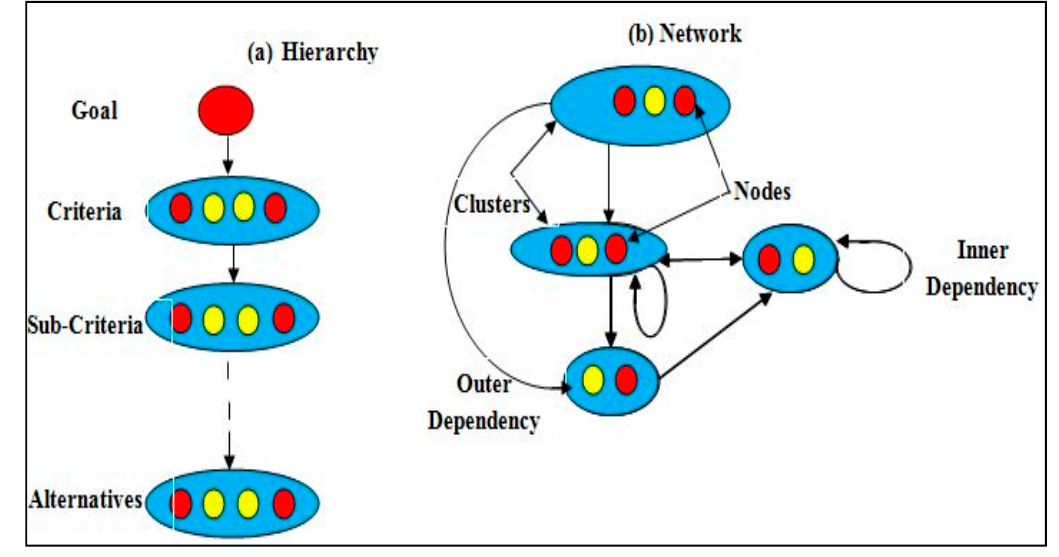
Figure 1. AHP ( a ) and ANP ( b ) structures.